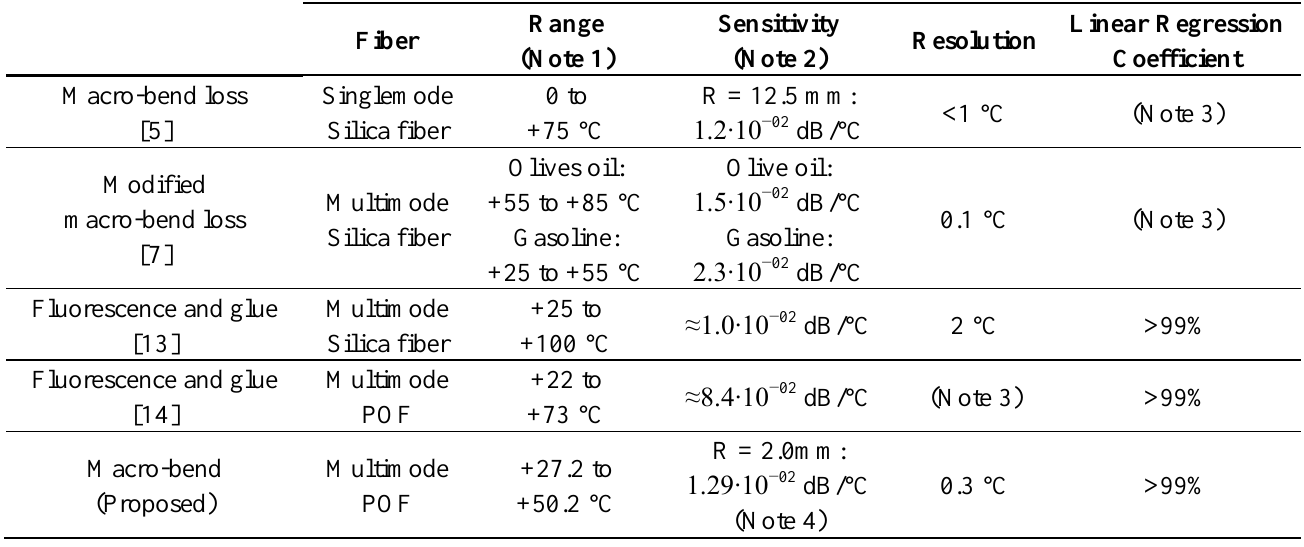
Table 1. Comparative table with other intensity fiber-optic temperature